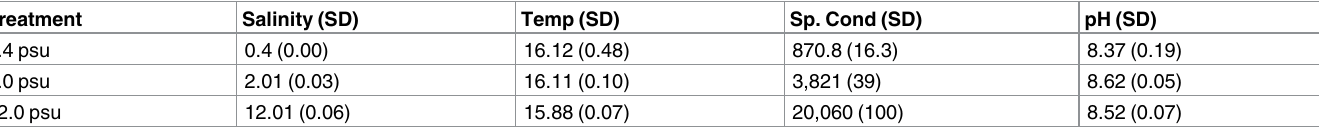
Table 2. Temperature (˚C), salinity (psu), specific conductivity ( μ S/cm)and pH of the treatment tanks averagedacross the acclimation and experi- mental period for the metabolism experiment. Standarddeviations are in parentheses.